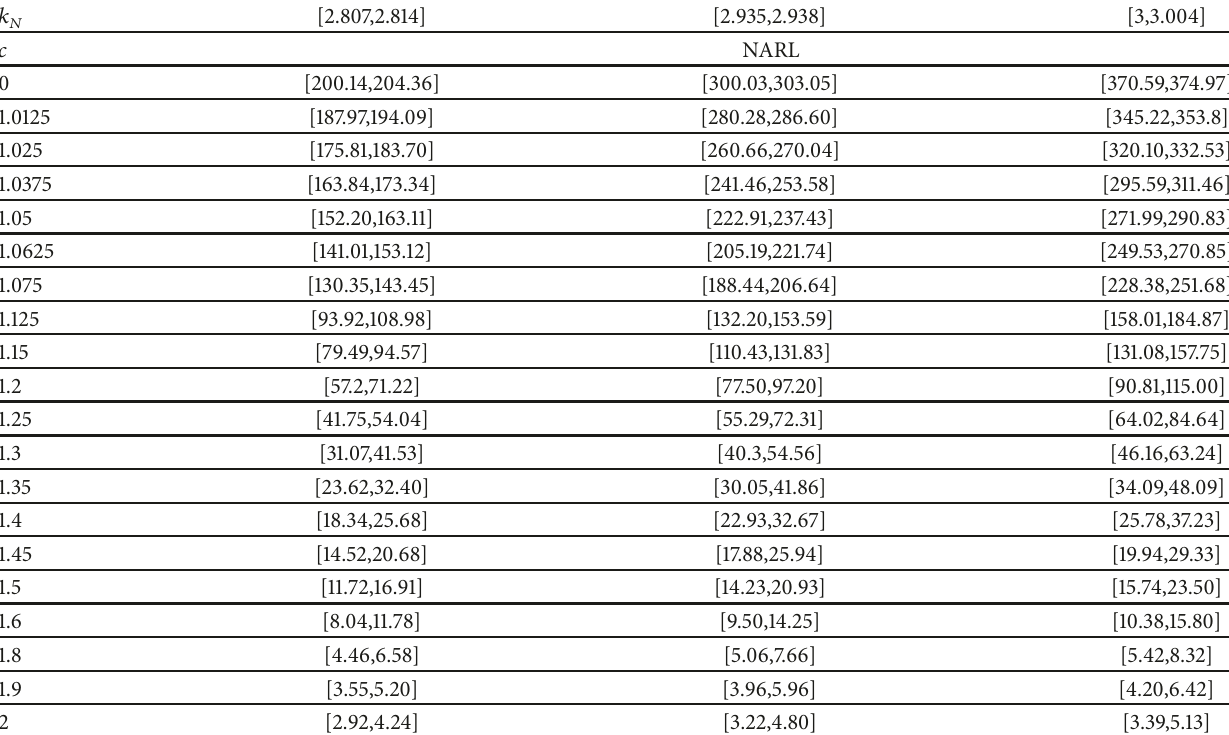
Table 2: The NARLs of proposed chart when V 𝑁 𝜖[0.9,1.1] and 𝑢 0𝑁 𝜖[3.5,4.5] .